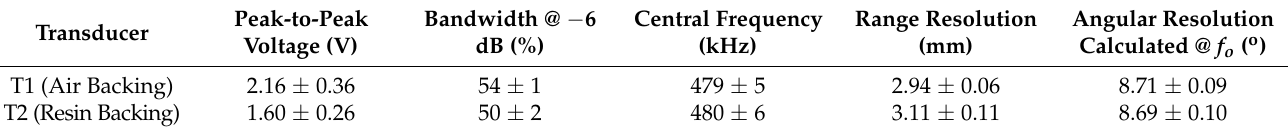
Table 3. Characteristics measured with echoes from transducers T1 and T2 excited with a single rectangular negative pulse.